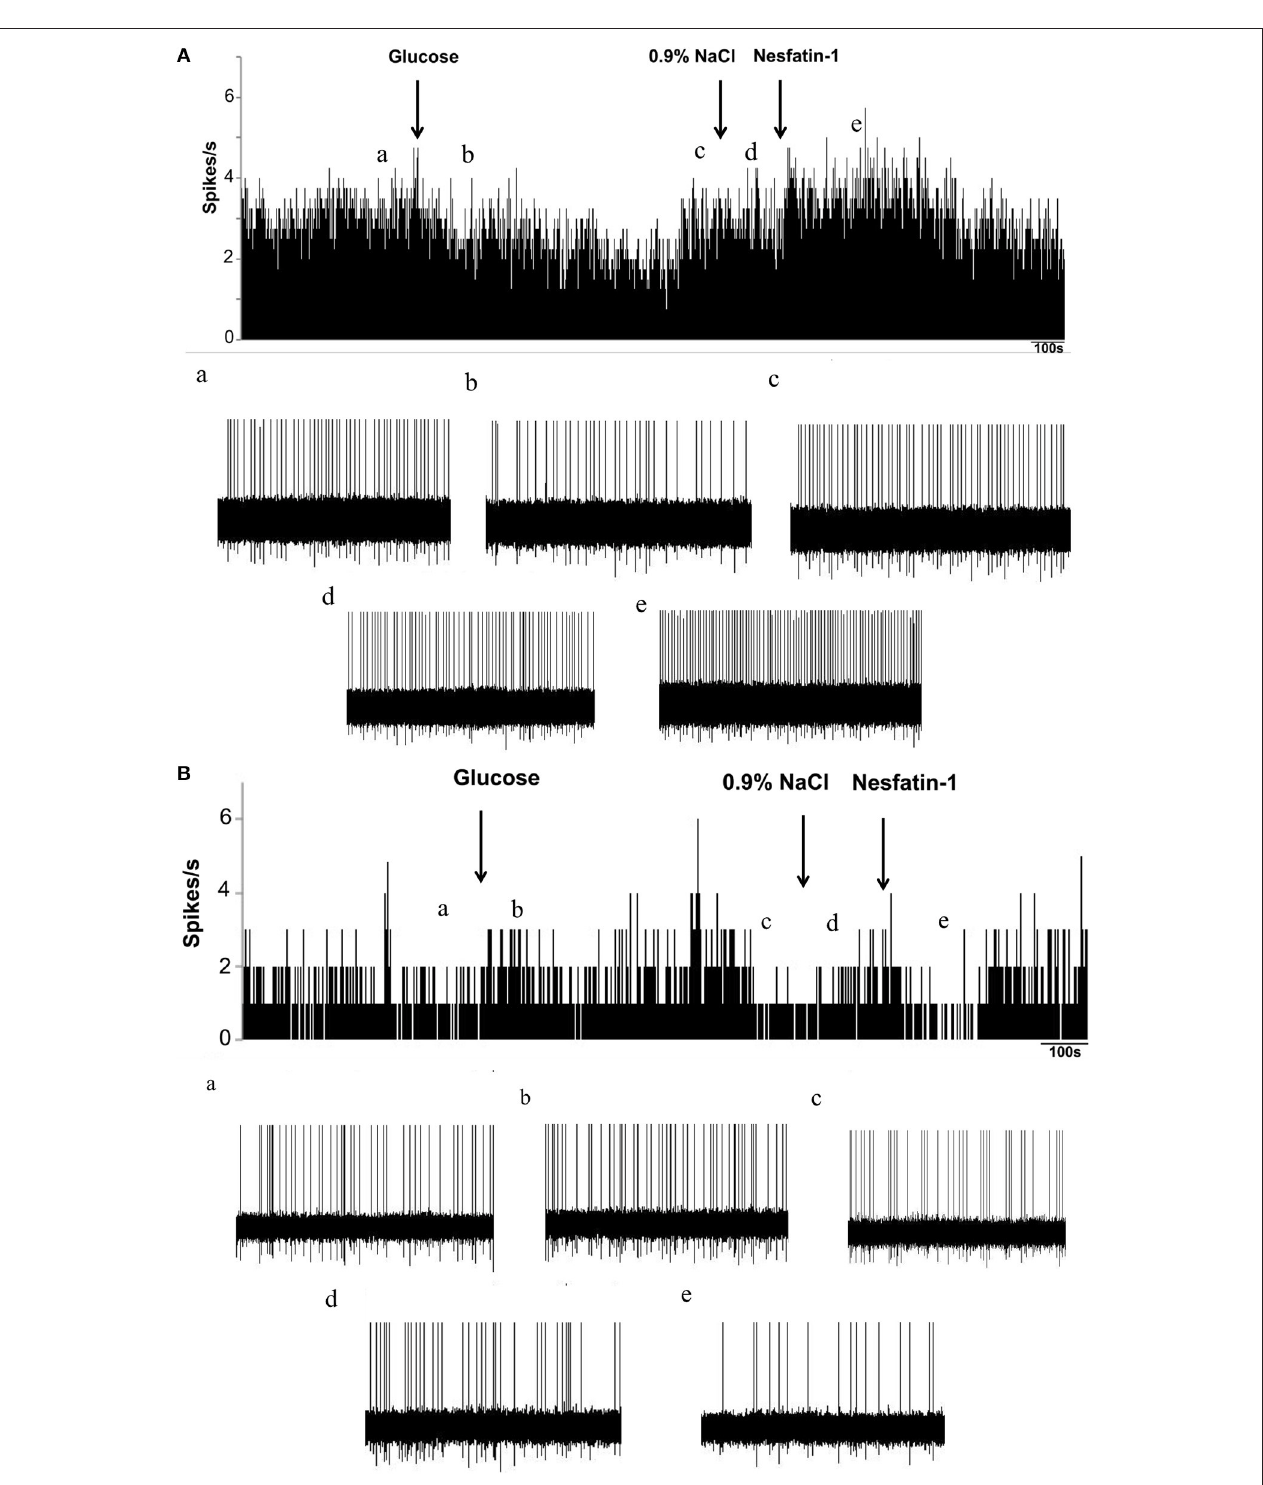
FIGURE 3 | Effects of nesfatin-1 on glucosensing neurons in the LPBN. (A) Representative stimulation of a GI neuron in the LPBN by nesaftin-1. The first arrow indicates addition of 5 mM glucose, the second arrow indicates the 0.9% NaCl-treated control, and the third arrow indicates nesfatin-1 (1.5 × 10 − 8 M) application. (B) Representative inhibition of a GE neuron by nesaftin-1. (a) Baseline before glucose application. (b) Firing rate after glucose application. (c) Firing rate recovered to baseline before 0.9% NaCl application. (d) Firing rate after 0.9% NaCl application and the baseline before nesfatin-1 application. (e) Firing rate after nesfatin-1